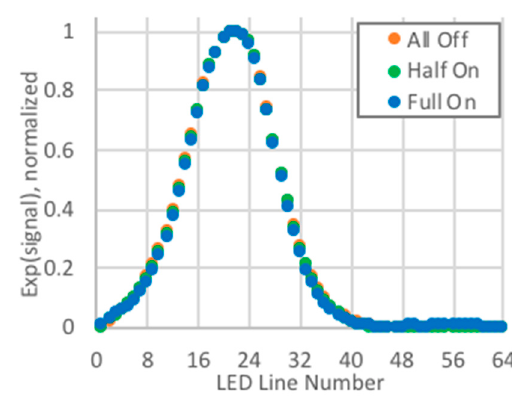
Figure 17. Normalized signal.